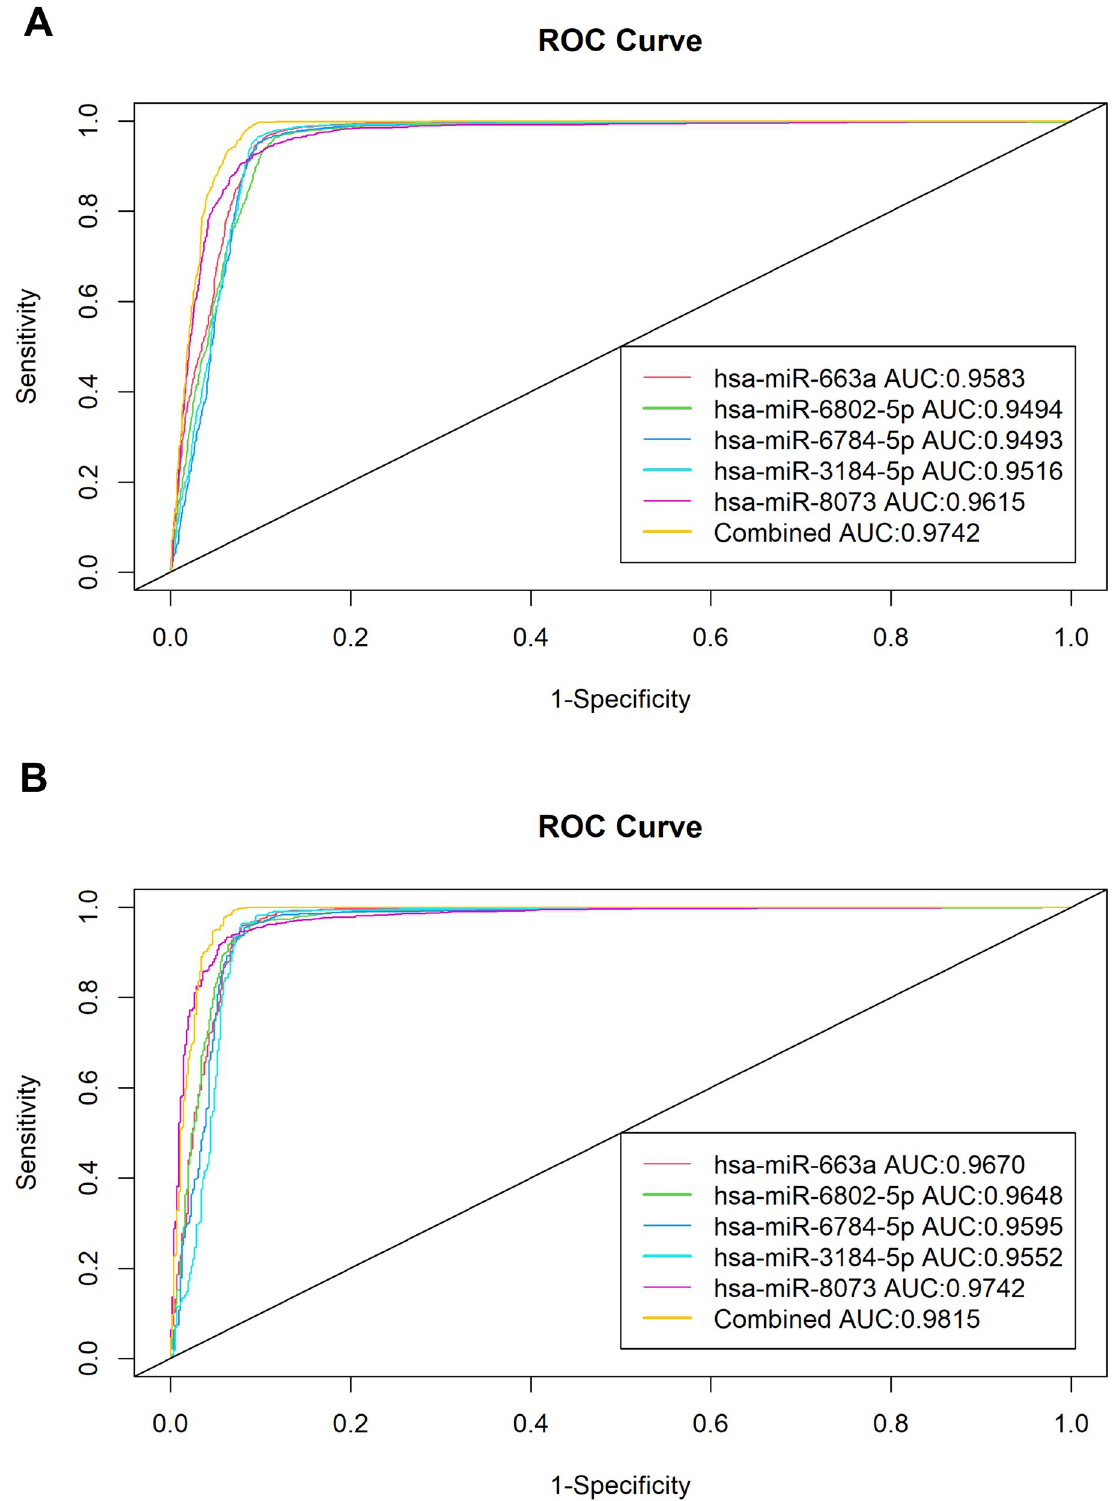
Fig 3. ROC and AUC analysis of the top 5 selected miRNAs and the 4 miRNA combination ROC and AUC values. Panel A is the analysis for the discovery set. Panel B is the analysis for the Validation Set. Both panels achieved the highest ROC and AUC value using 4 miRNAs: has-miR-663a, has-miR-6802, has-miR-3184-5p, and hsa-miR-8073.